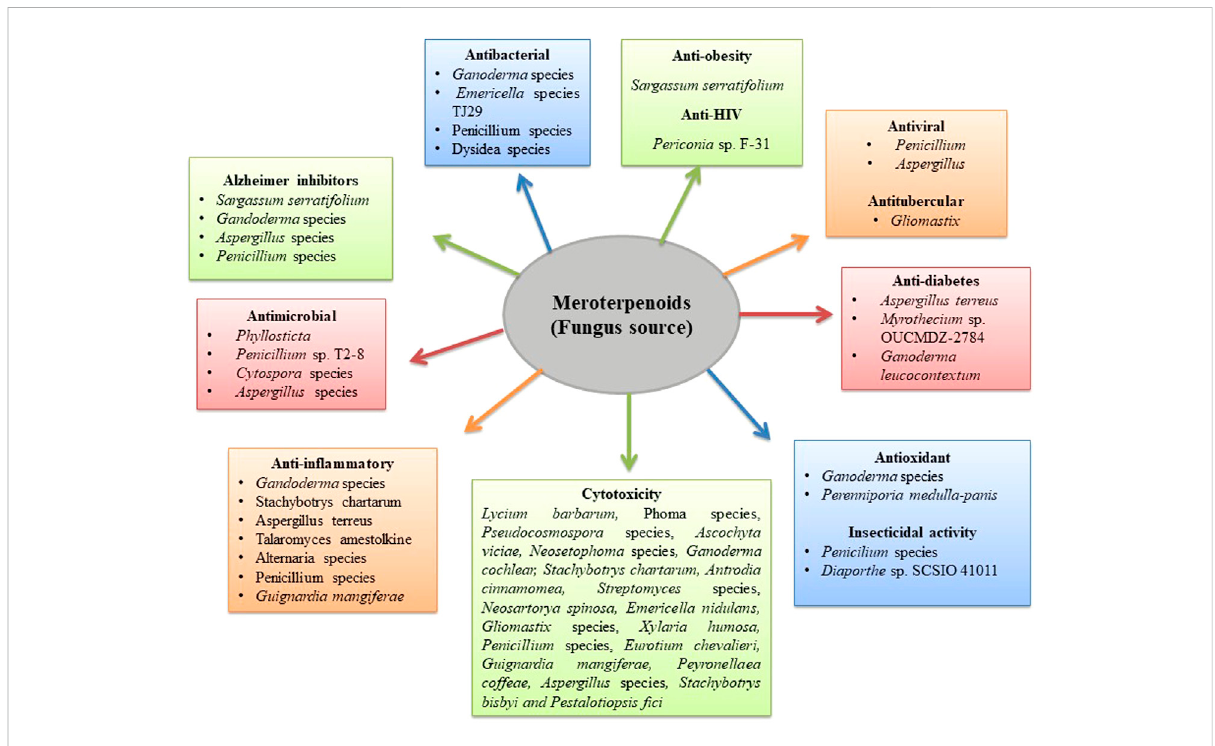
FIGURE 1 Biological activity of fungus